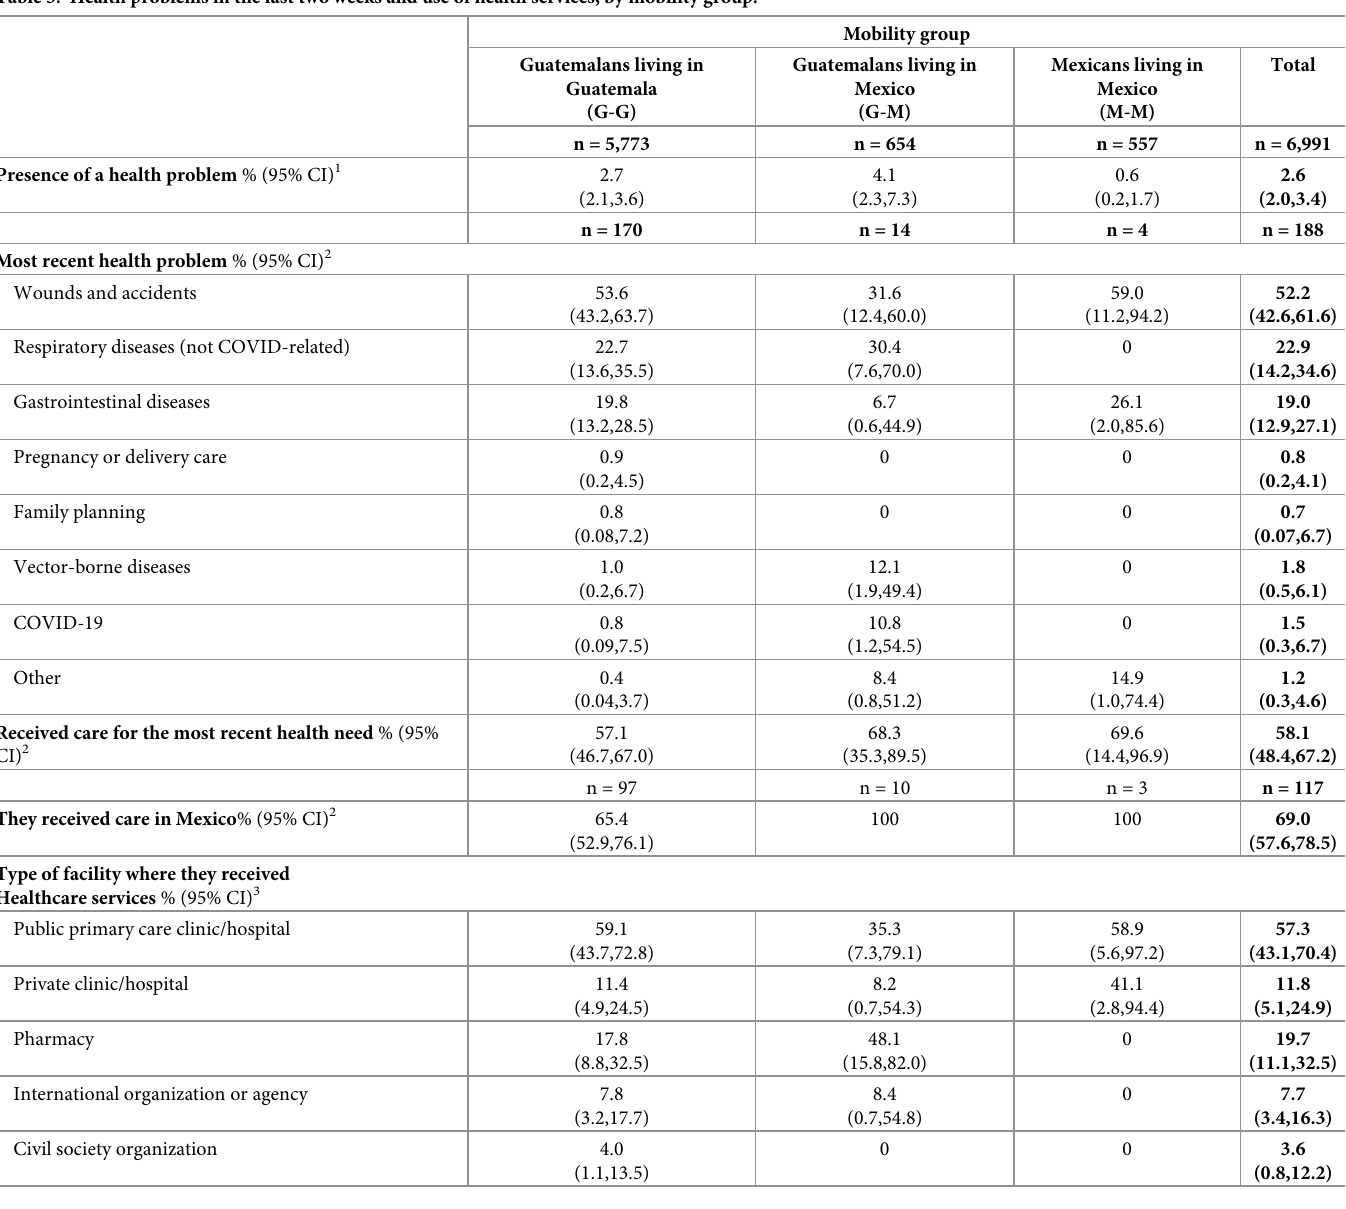
Table 3. Health problems in the last two weeks and use of health services, by mobility